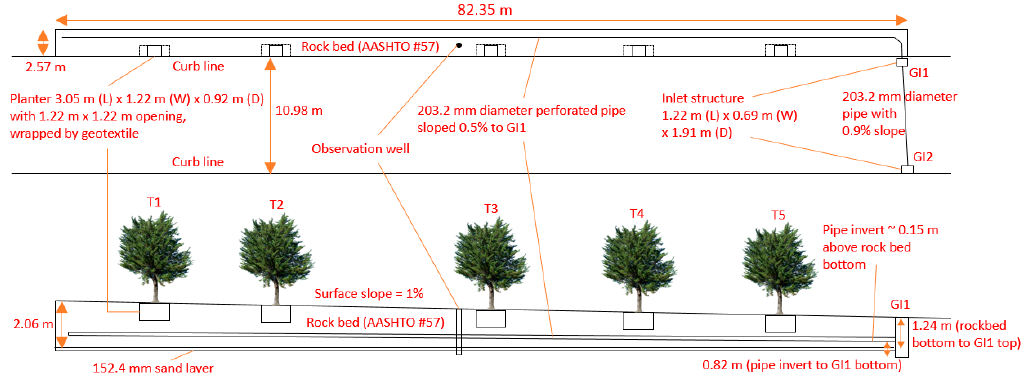
Figure 1. The green infrastructure (GI) system under investigation; plan view (top) and profile view (bottom). Reprinted from Tu and Traver [24].